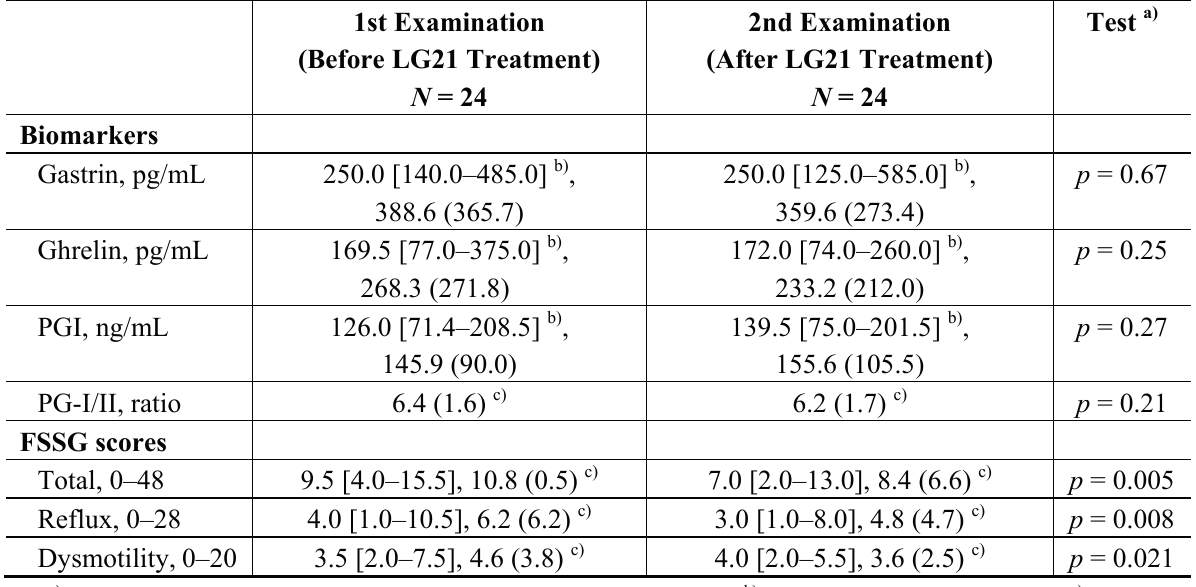
Table 2. Effect of the LG21 treatment on the biomarker values and the FSSG